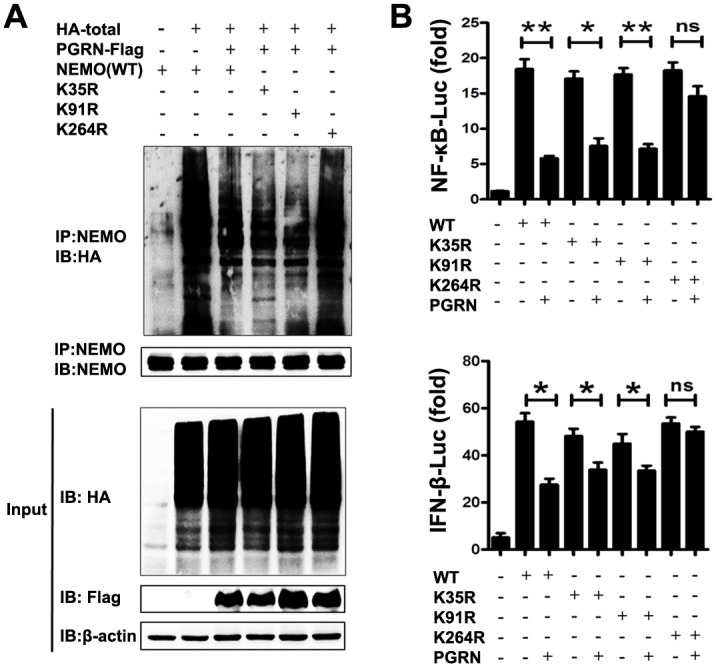
PGRN inhibits NEMO ubiquitination at Lys264.(A) Immunoblotting of HEK293 cells co-transfected with vectors encoding Myc- tagged NEMO or NEMO mutants bearing substitutions of Lys35 (K35R), Lys91 (K91R) or Lys264 (K264R) along with either empty vector or a vector encoding FLAG-tagged PGRN. Data are representative of three independent experiments. (B) HEK293 cells were transfected with (i) empty vector or plasmids encoding NEMO or NEMO mutants bearing substitutions of K35R, K91R or K264R together along with (ii) an empty vector or a PGRN-encoding vector. After 18 h, NF-κB and IFN-β activity was measured using luciferase reporter assays. Data are pooled from three independent experiments performed in triplicate. Error bars indicate SEM. *p < 0.05; **p < 0.01.